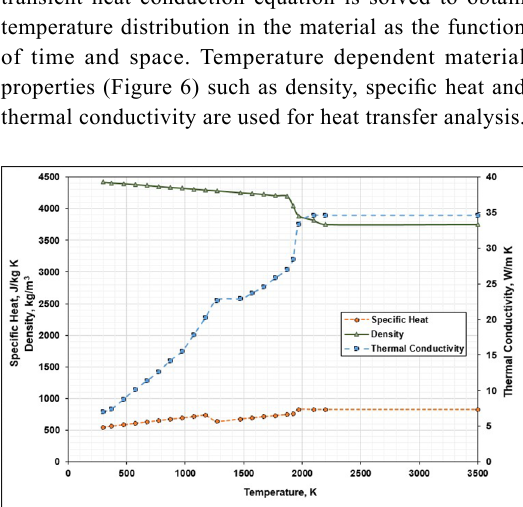
Figure 6. Temperature Dependent material properties of